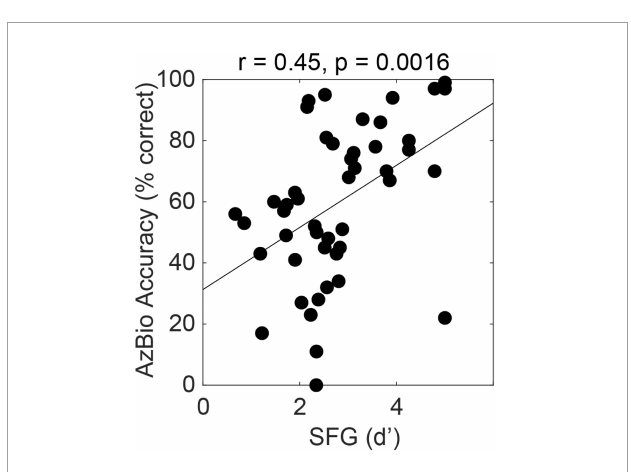
FIGURE2 Correlation between performance for the figure ground task (SFG, stochastic figure ground) and a widely used US measure of sentence-in-noise perception, AzBio. The data are for 47 cochlear-implant users (see text).